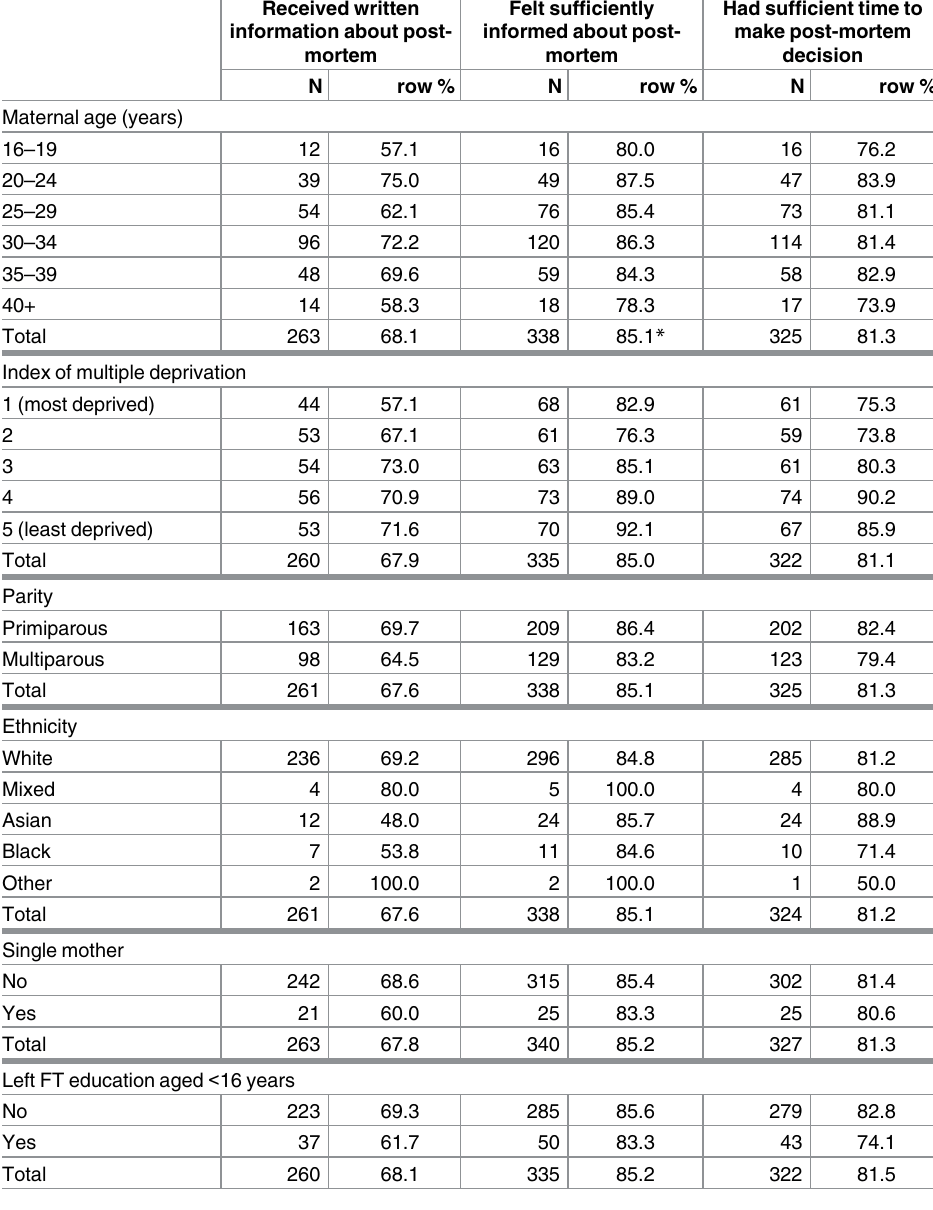
Table 2. Proportion of women who receivedwritten information, whether they felt sufficiently informed, and whether they had time to decide about